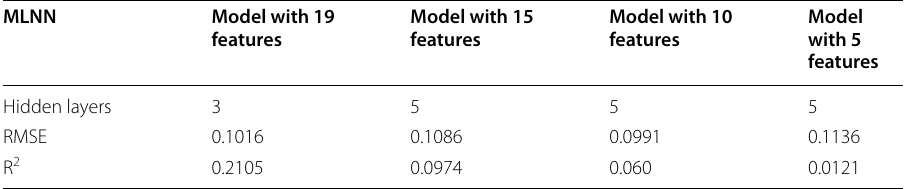
Table 12 Performance metrics with MLNN